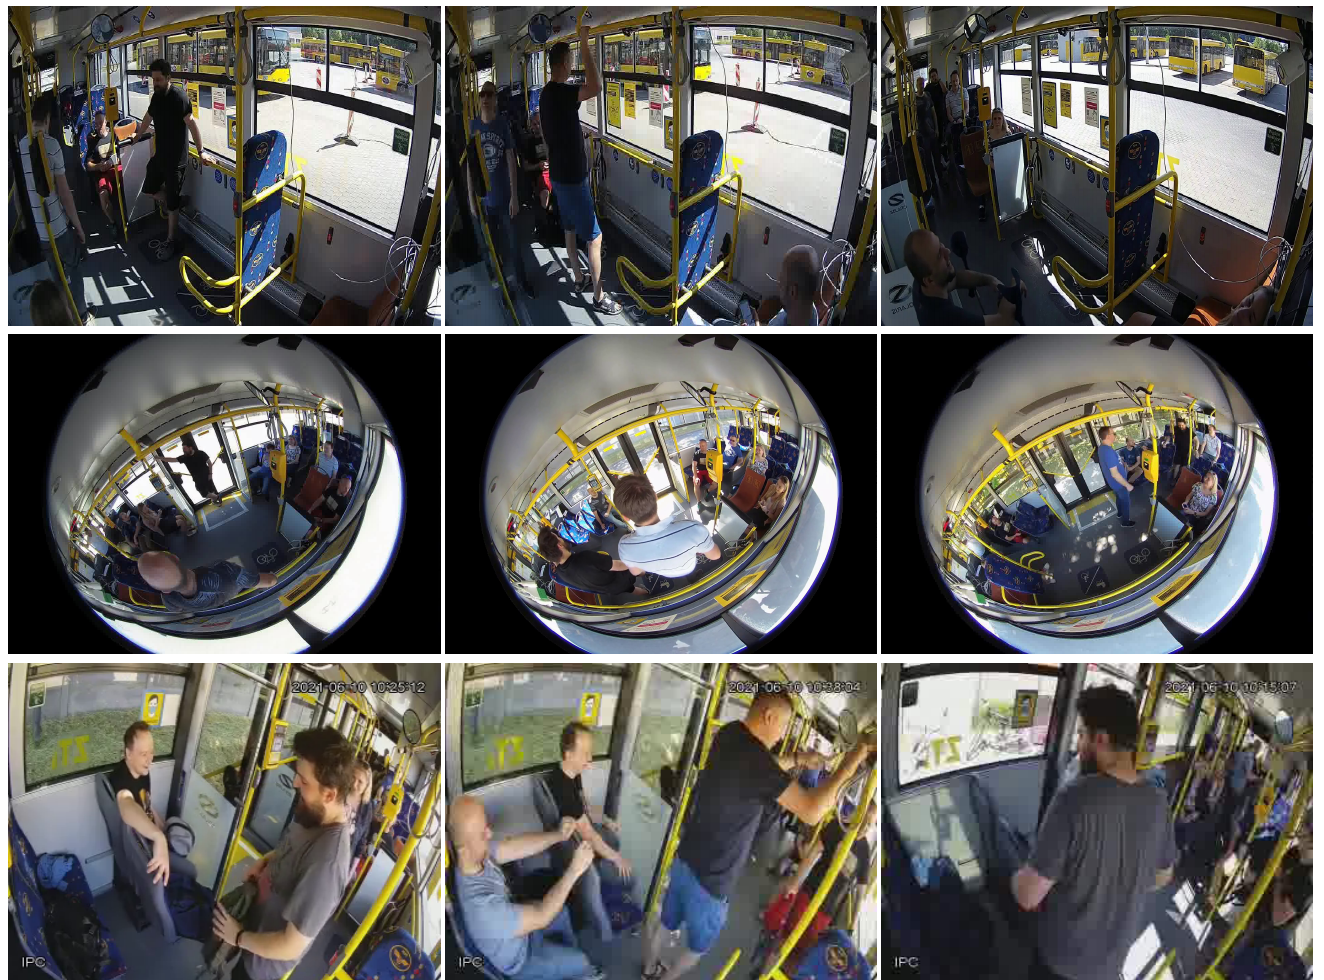
Figure 2. Samples of our Bus Violence benchmark belonging to the non-violence class, where the actors were just sitting, standing, or walking inside the bus. Each row corresponds to a different camera having a different